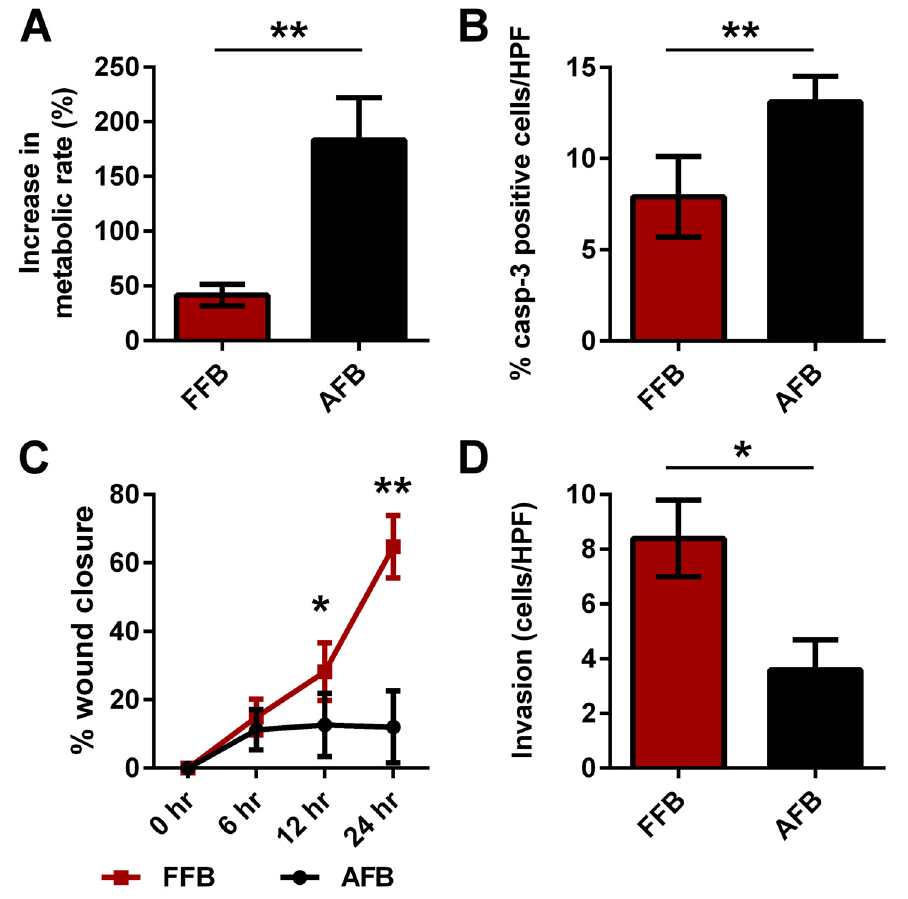
Fig 1. Differences in the functional profile of FFB compared to AFB. A) Rate of metabolism, B) apoptosis, C) migration and D) invasion were compared between FFB and AFB. Bar plots represent average ± SD. Asterisks denote statistically significant differences between the groups ( * p < 0.05, ** p < 0.01; Student ’ s t-test; n = 3 per group at similar passage number; each experiment was conducted in triplicates with cells from independent